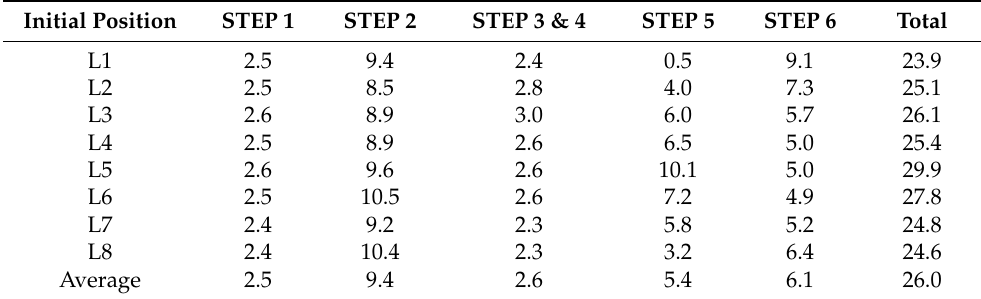
Table 3. Average time required during the landing procedure. Ten trials were conducted for every